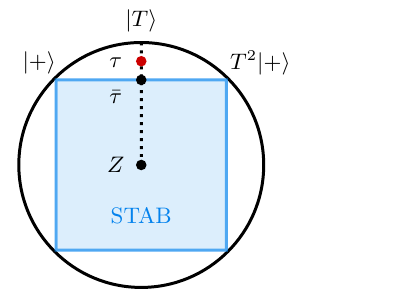
FIG. 1. The cross section of the Bloch sphere through the cen- ter perpendicular to the Z axis. The blue square represents the corresponding cross section of the stabilizer hull (STAB). ¯ τ is √ 2 depolarizing noise and lies actually | T (cid:10) subject to p = 1 − 1 / on the edge of STAB. τ is the noisy input state that lies between | T (cid:10) and ¯ τ .